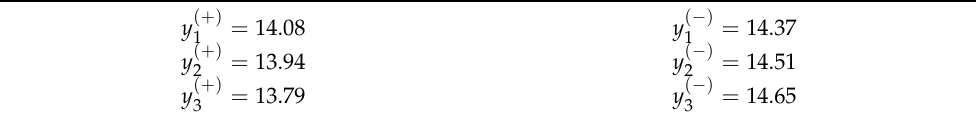
Table 5. Torsion box width values (dimensions in